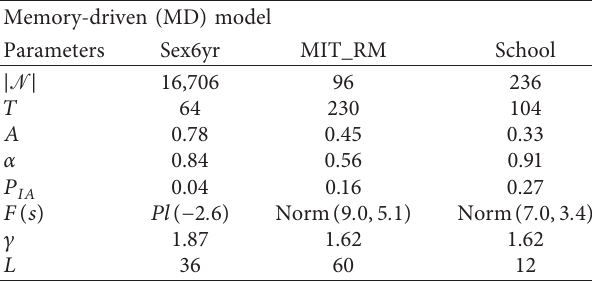
Figure 5: (a) Transition probabilities of individual activity states in the MD network model. (b) Contact establishment strategies of each agent in each time step: social keeping (blue) and social exploring (white). Table 2: The parameters of the memory-driven